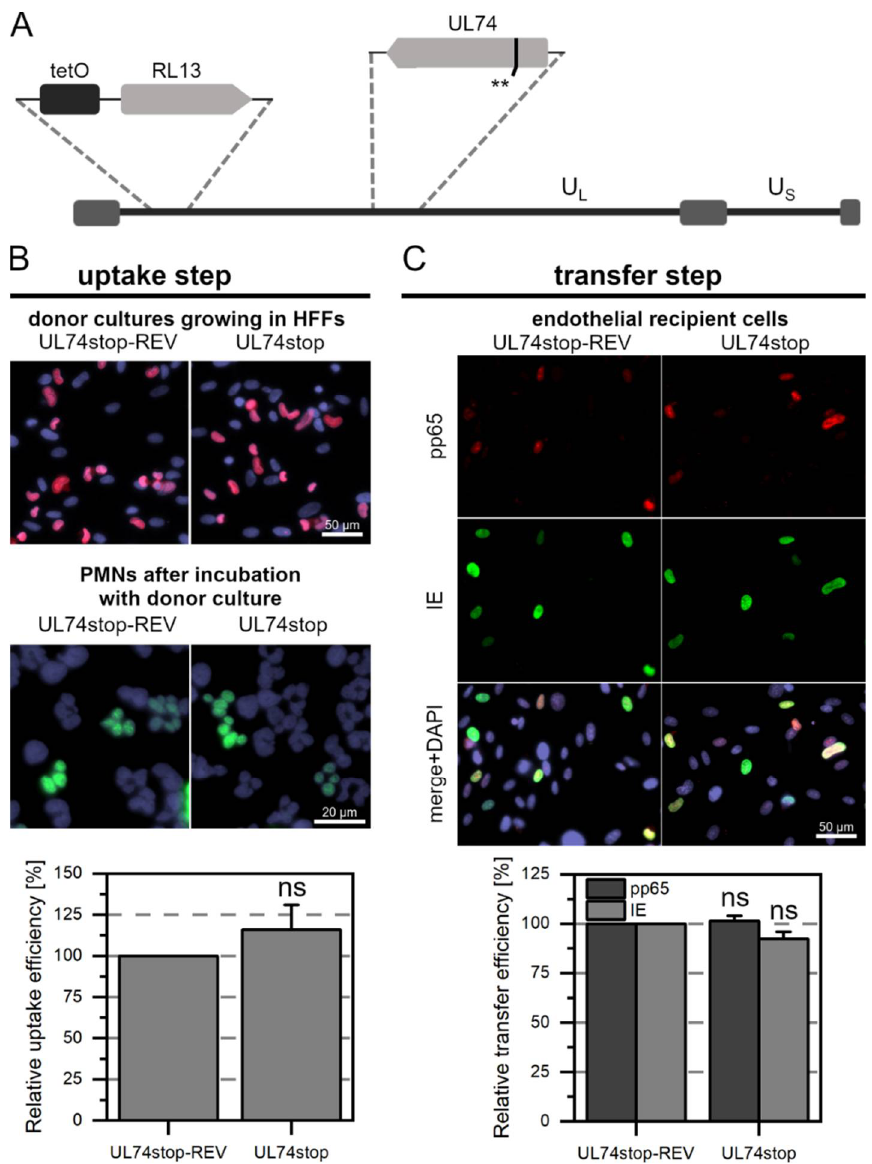
Figure 3. The trimeric complex of HCMV is dispensable for uptake into PMNs and subsequent transfer to endothelial cells. ( A ) Genomic overview of the generated Merlin mutant representing the unique long (U L ) and short (U S ) sections: the mutant carries the tet operator upstream of RL13. In comparison to the wild-type, two consecutive stop codons (**) were introduced into the ORF of